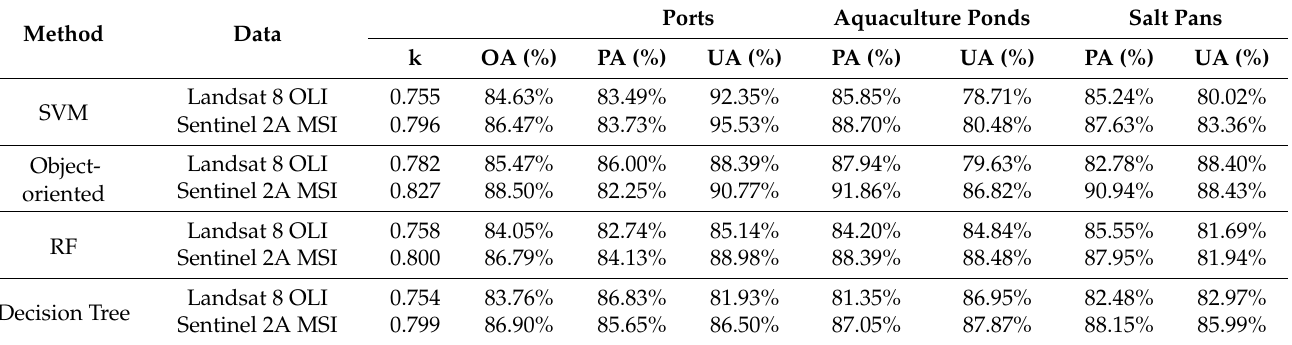
Table 8. Accuracy validation in the Pearl River Delta.